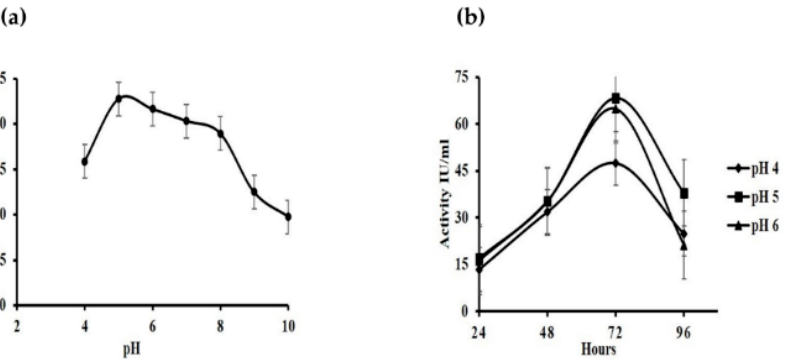
Figure 5. ( a ) Effect of initial medium pH on endoPGase activity; ( b ) effect of pH on enzyme produc- tion with relation to the fermentation